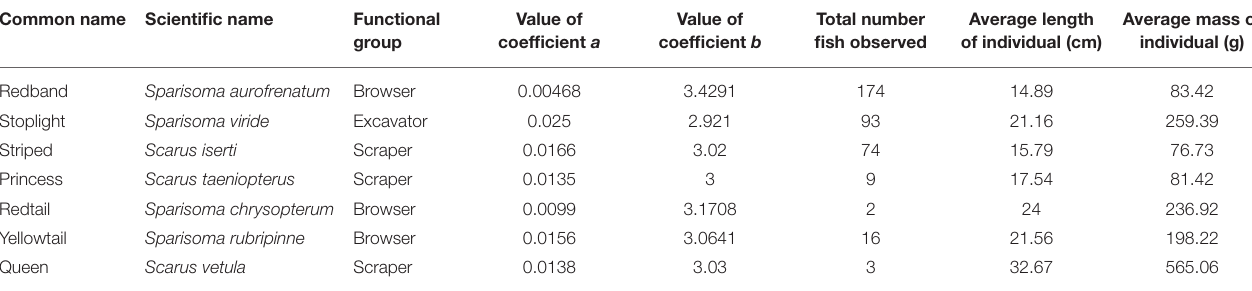
TABLE 2 | Parrotfish species observed and coefficient values used in biomass